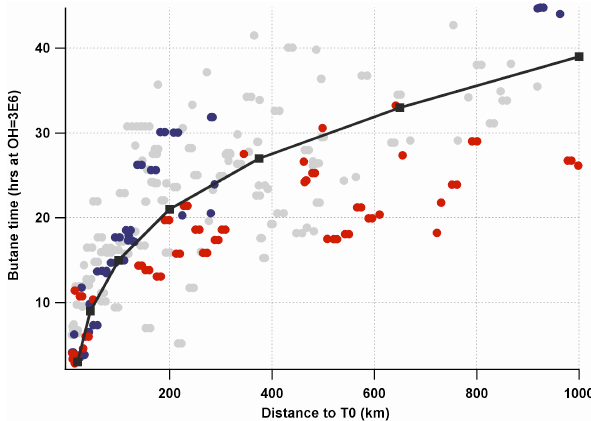
700 Fig. 3. The relationship between the age calculated from the ratio Figure 3) The relationship between the age calculated from the ratio of 2-butyl nitrate to 701 of 2-butyl nitrate to n-butane and the distance to the T0 site in the n-butane and the distance to the T0 site in the center of Mexico City. Gray points show 702 center of Mexico City. Gray points show all data that traces back to all data that traces back to Mexico City, red points represent DC-8 Flight 7 and blue 703 Mexico City, red points represent DC-8 Flight 7 and blue points rep- points represent DC-8 Flight 8, two flights for which the average wind speed varied 704 resent DC-8 Flight 8, two flights for which the average wind speed widely as discussed in the text. The black line represents a qualitatively typical 705 varied widely as discussed in the text. The black line represents a relationship.706 qualitatively typical